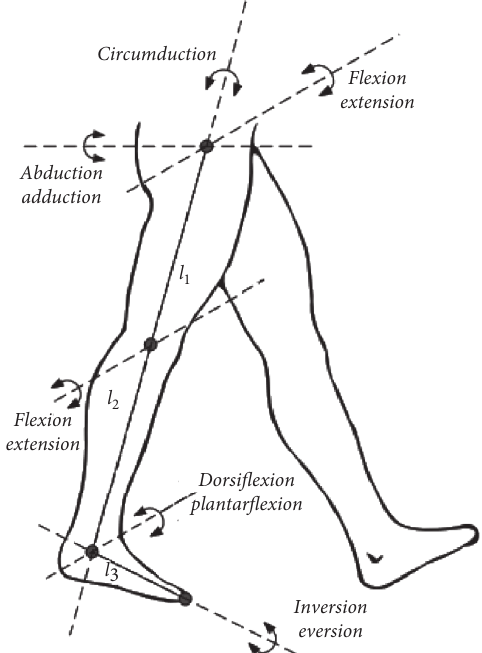
Figure 7: Human leg DoF orientation [45].